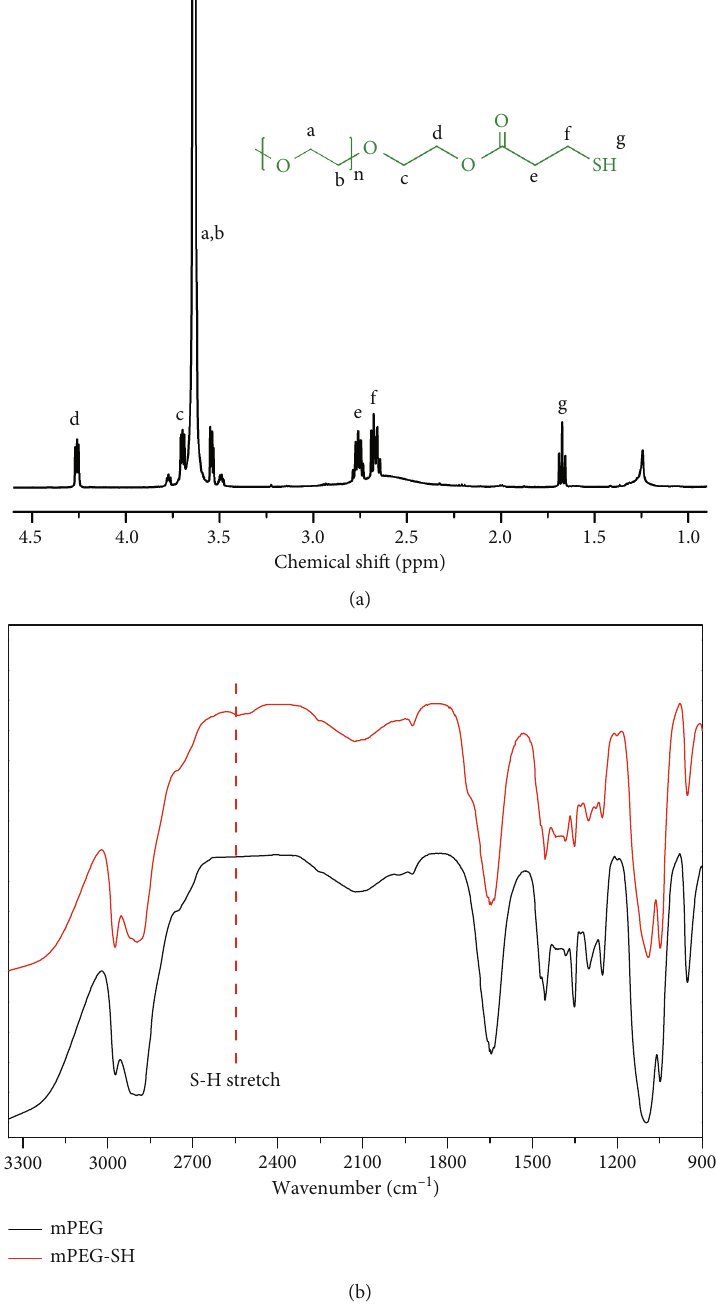
Figure 2: (a) 1 H-NMR spectrum of mPEG-SH; (b) IR spectrum of mPEG before and after